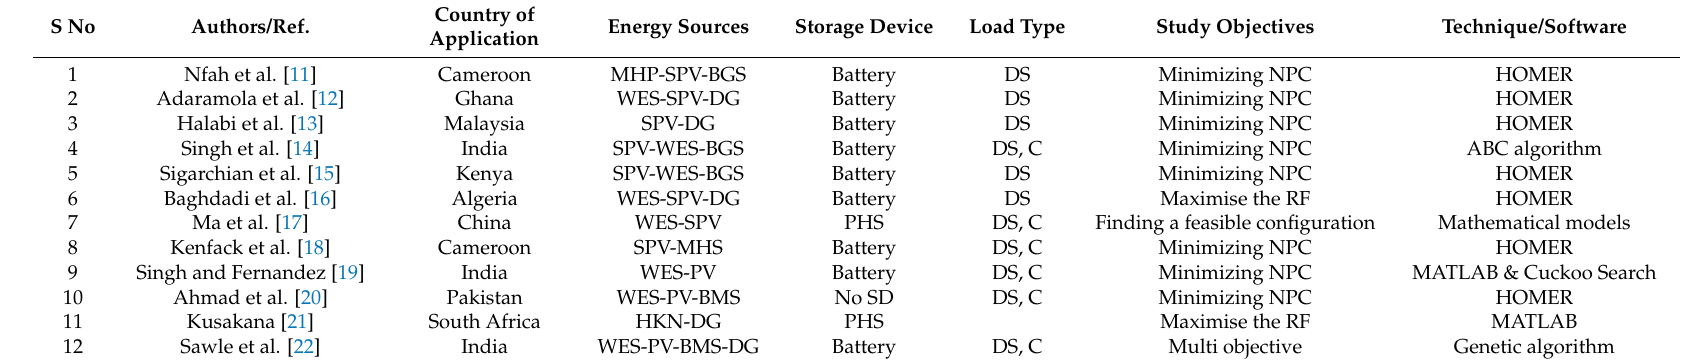
Table 1. Selected studies on hybrid renewable energy systems (HRES) in developing